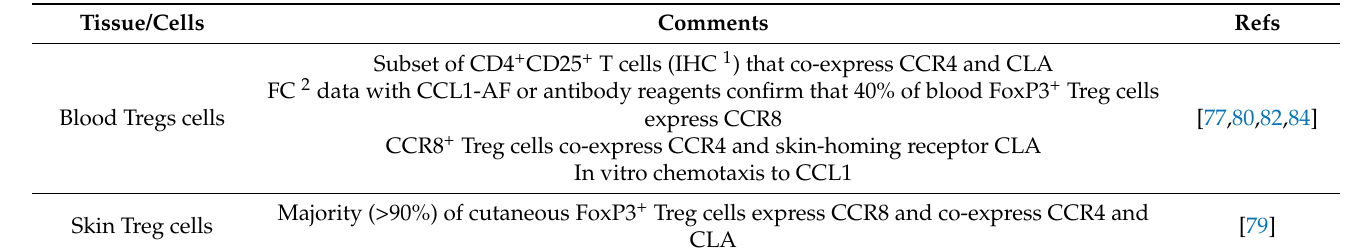
Table 1. Cellular distribution of human